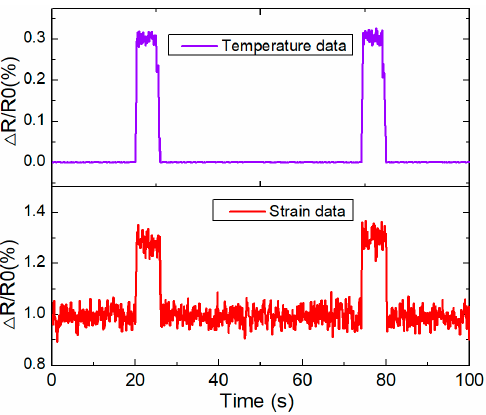
Figure 12. The strain and temperature sensing data from the SMFS embedded into WSN nodes for cooperative data collection from the track.